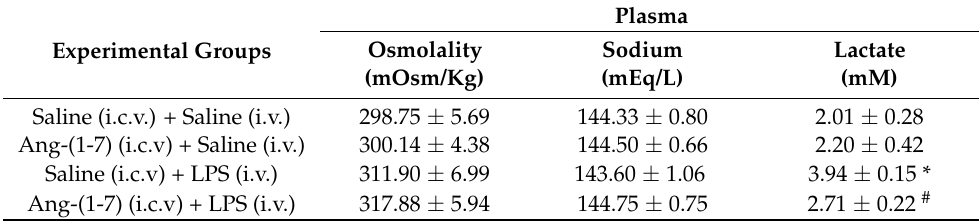
Table 1. Effect of central Ang-(1-7) administration in osmolality, sodium, and lactate plasma levels of the endotoxemic